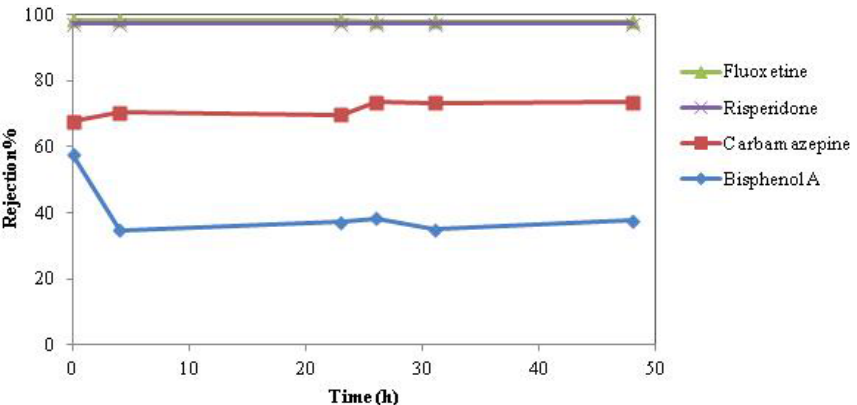
Figure 3. Temporal changes for rejection of fluoxetine, risperidone, carbamazepine and bisphenol A rejection by new NF270 membrane.